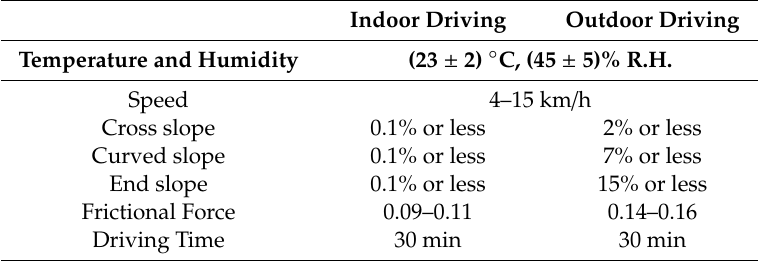
Table 3. Temperature profile during vibration